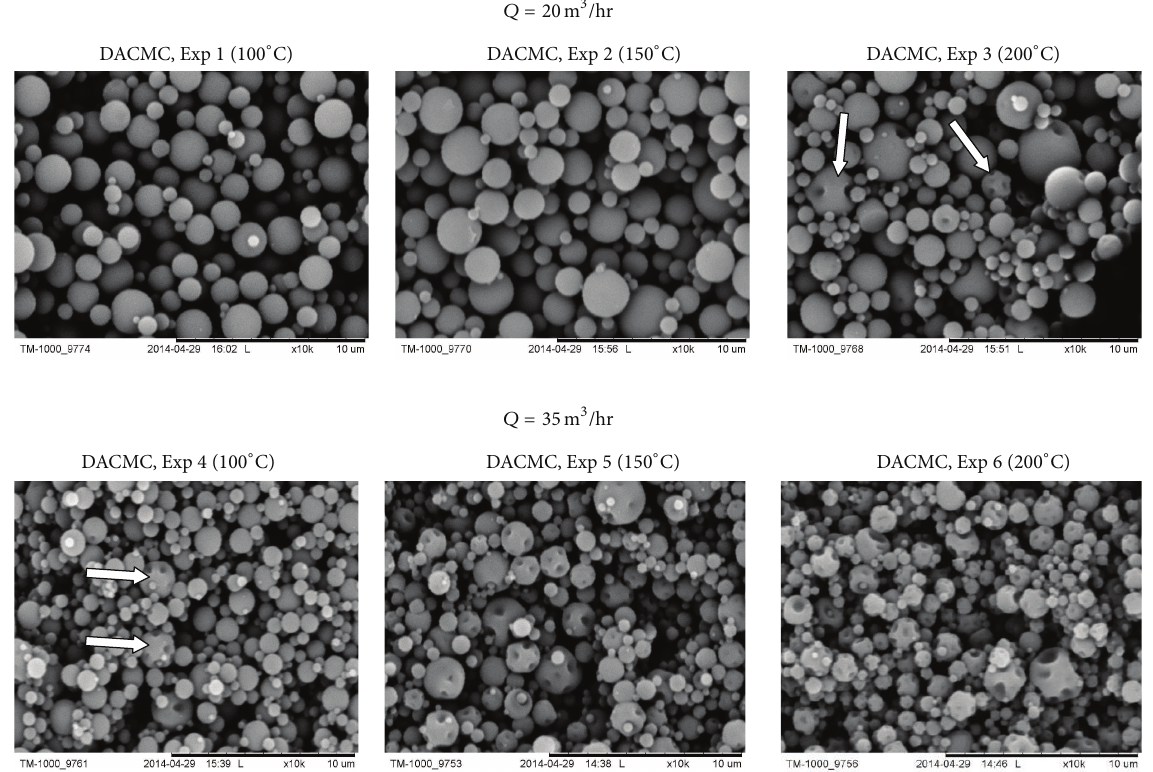
Figure 4: SEM pictures of powders obtained by spray drying of DACMC nanosuspensions. Arrows indicate deformed particles with a wrinkled surface.